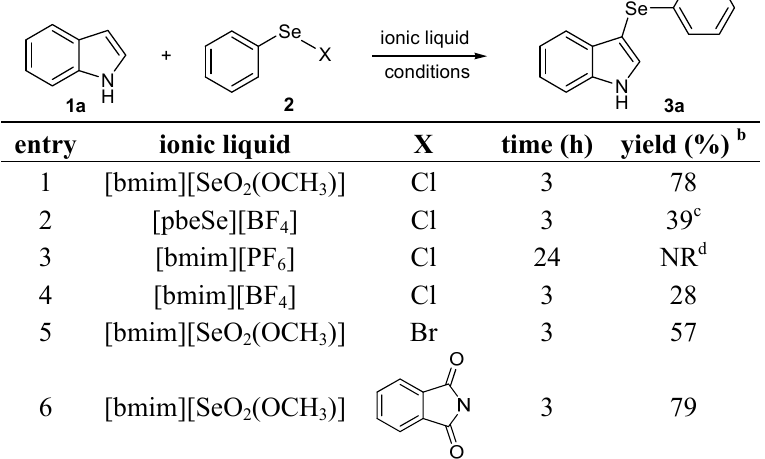
Table 1. Optimization studies for preparation of 3-(phenylselenyl)-1 H -indole a . conditionsionic